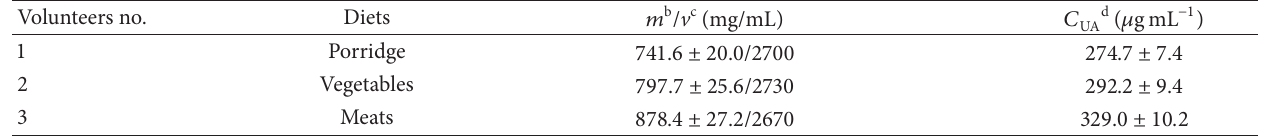
Table 2: Determination of 24h urine UA excretion a .